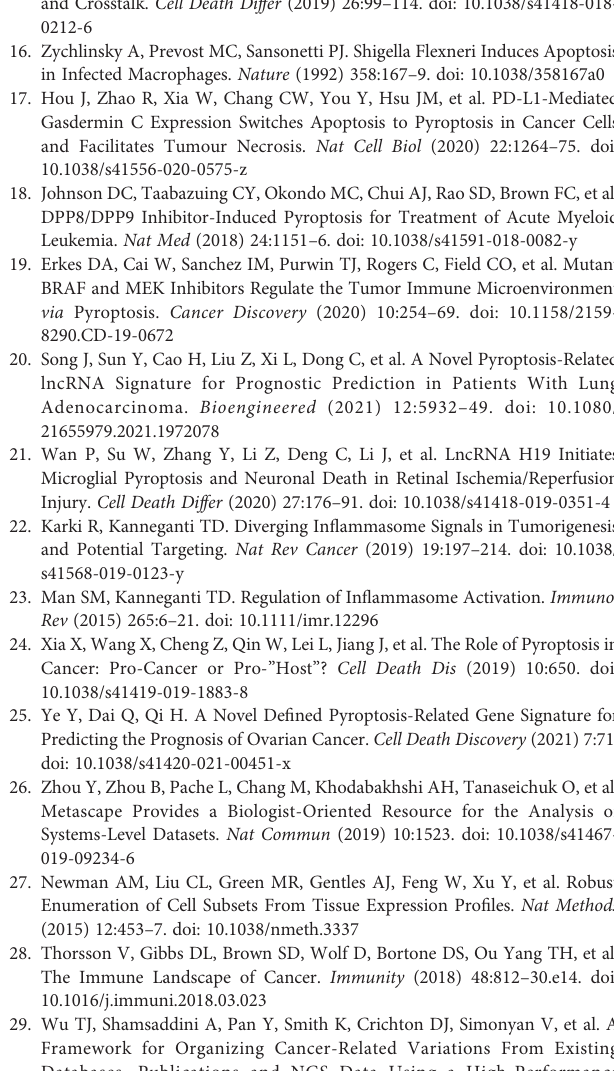
Supplementary Figure 1 | The immune cell in fi ltration of different risk score groups, which calculated by the TIMER, CIBERSORT, XCELL, QUANTISEQ, MCPcounter, EPIC, and CIBERSORT-ABS algorithm (A) : CIBERSORT; (B) : CIBERSORT-ABS; (C) : QUANTISEQ; (D-E) : XCELL; (F) : EPIC; (G) : MCPCOUNTER; (H) : TIMER). Supplementary Figure 2 | (A) : Disease-Free Survival curve of the two groups; (B) : Disease-Speci fi c Survival curve of the two groups; (C) : Progress Free Interval curve of the two groups; (D) : AUC of (E-F) : Univariate and multivariate Cox regression analysis for ccRCC with clinicopathological factors in the TCGA data. Supplementary Figure 3 | (A-D) : Scores of TIDE, MSI, and T-cell exclusion and dysfunction in different risk groups (*** p < 0.001); (E) : Heatmap of Subclass mapping analysis for predicting the likelihood of response to ICI therapy of different risk score